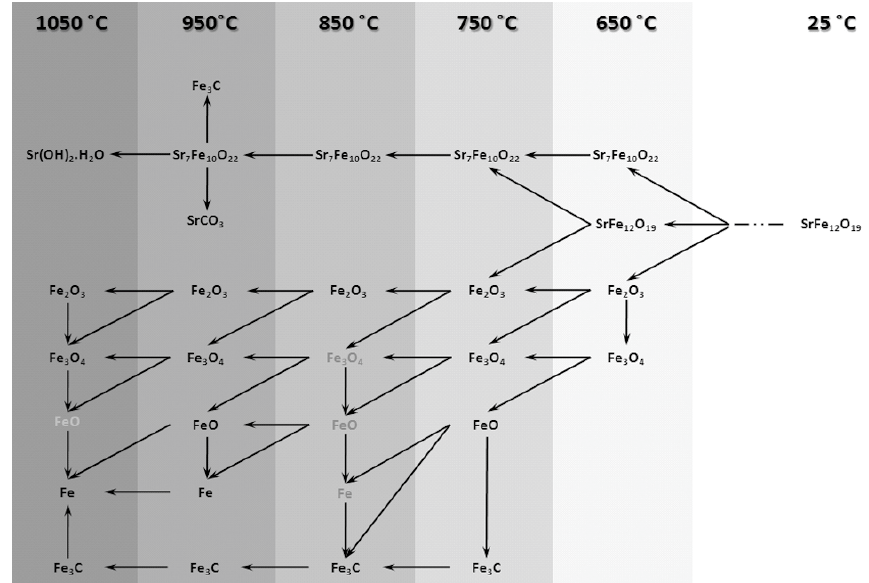
Figure 7. Phase transformation map suggested for the gas heat treatment of Sr ‐ hexaferrite.